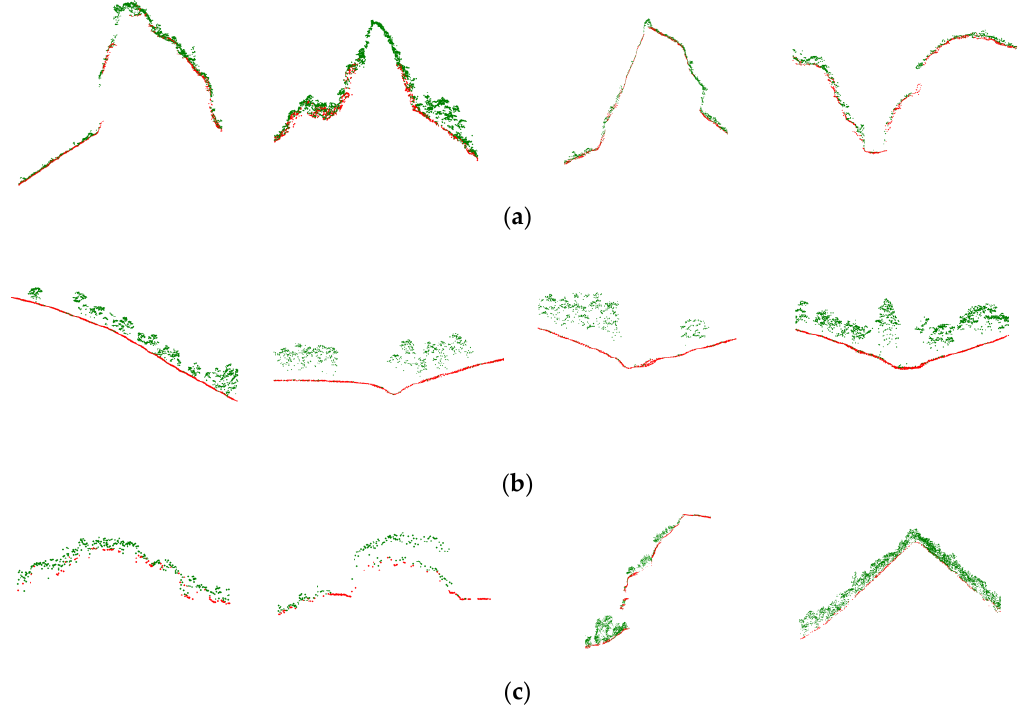
Figure 8. ( a–c ) Cross-sections of datasets I, II, and III, respectively. Red and green represent manual extracted ground points and non-ground points, respectively.